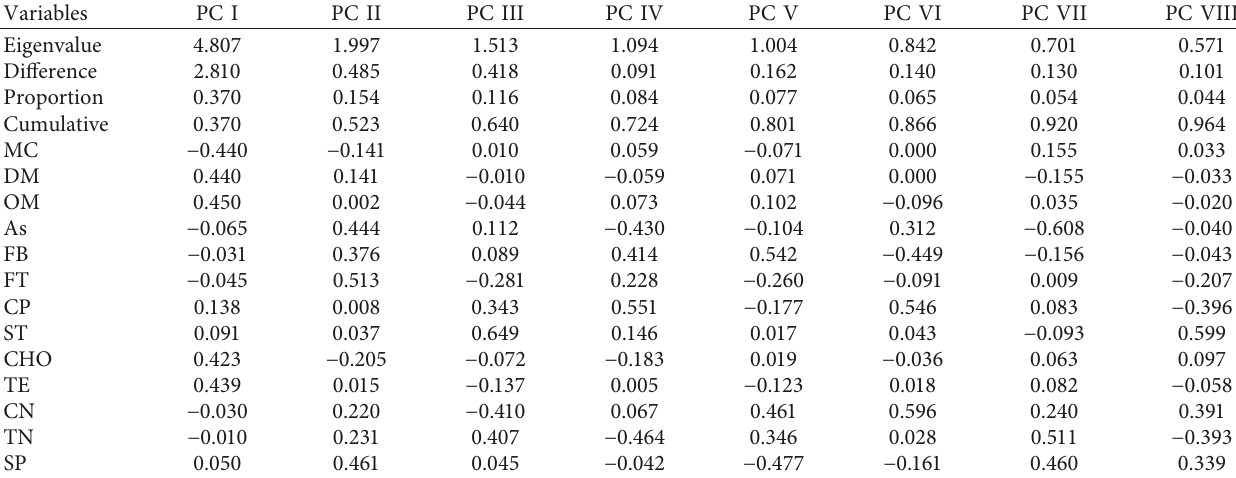
Table 6: Eigenvalues, difference, proportion, cumulative variance, and component scores.